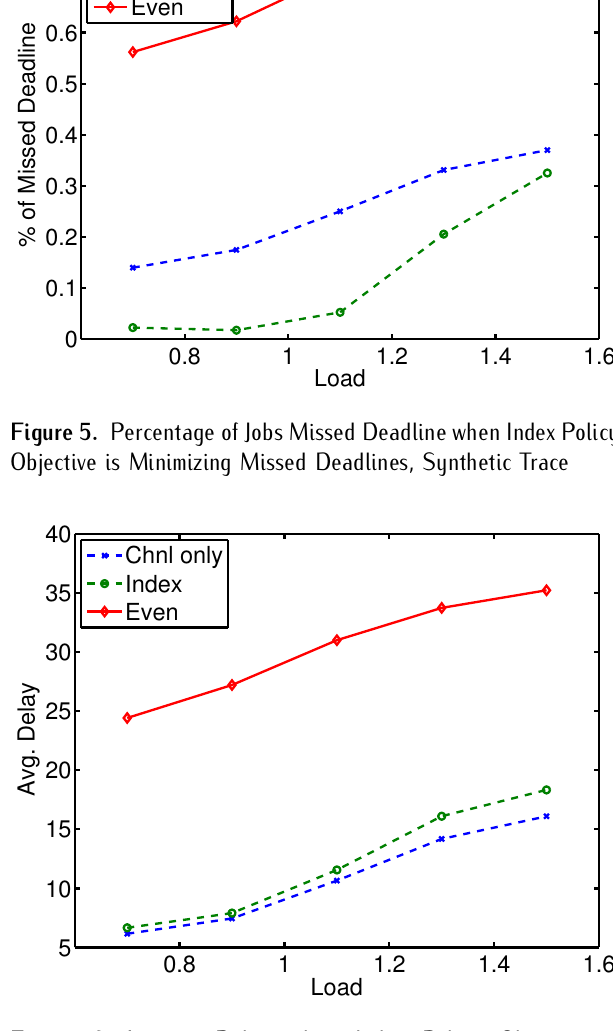
Figure 6. Average Delay when Index Policy Objective is Minimizing Missed Deadlines, Synthetic